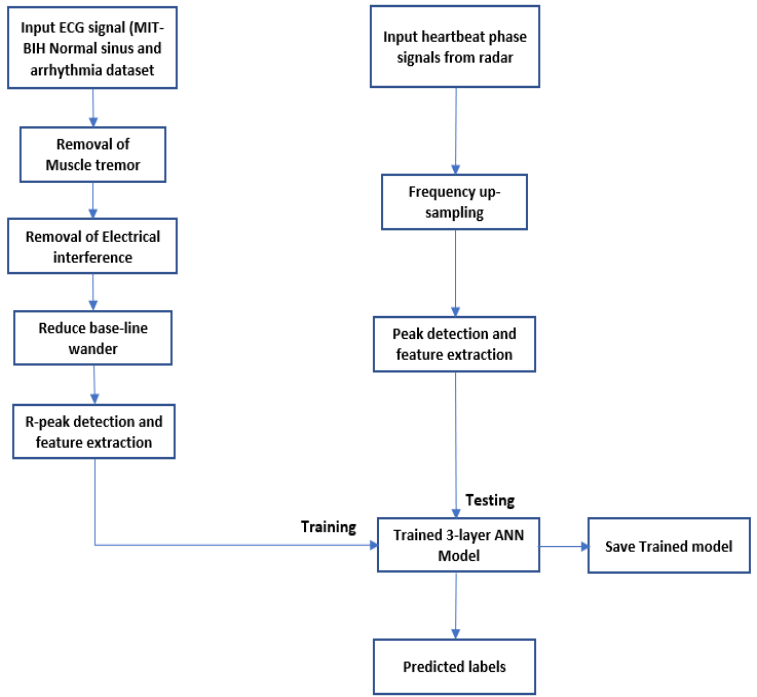
Figure 6. Predict the onset of arrhythmia based on statistical features extracted from the phase signals of a localized range bin using an FMCW radar.